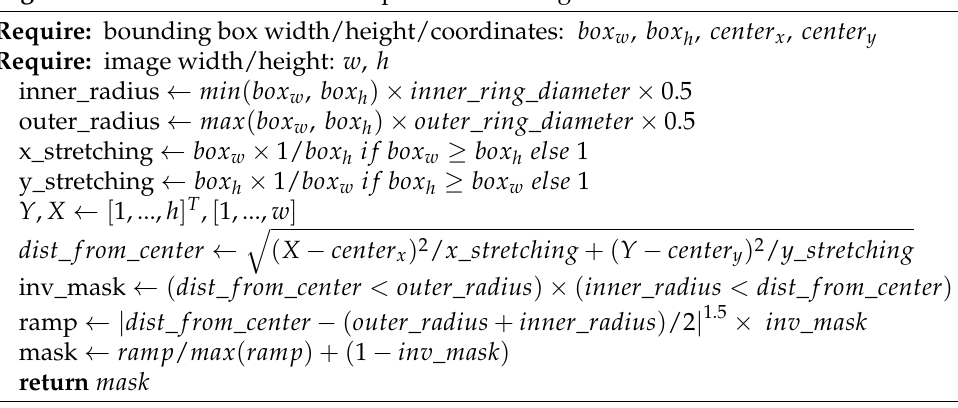
Algorithm 1 Loss mask for semi-supervised